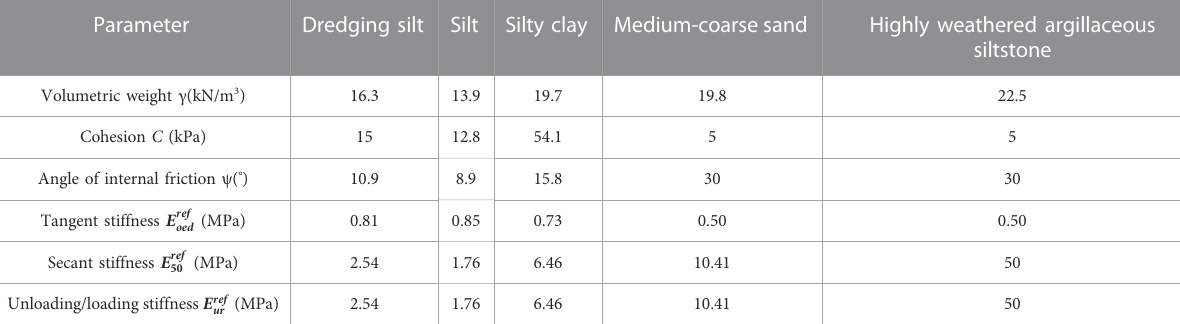
TABLE 3 Calculation parameters of the soil layer.